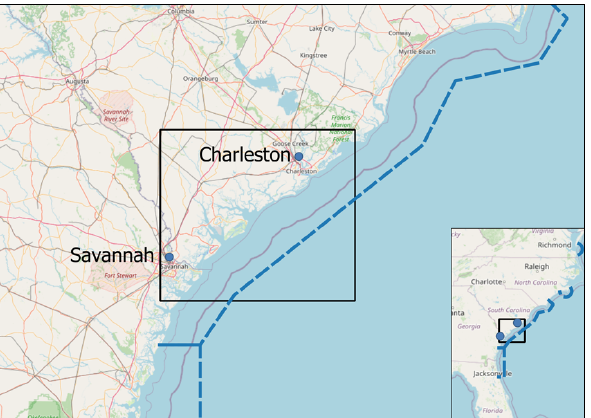
Figure 2. Area of interest with AIS data boundary marked in rectangle with ports of Savannah and Charleston. Right whale Seasonal Management Area (SMA) boundary marked with dashed line.